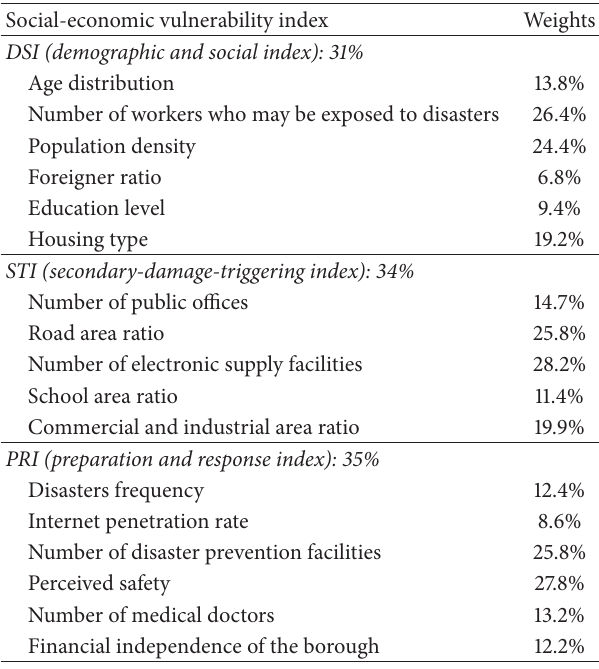
Table 3: Proxy variables and their weights in socioeconomic vulnerability assessment